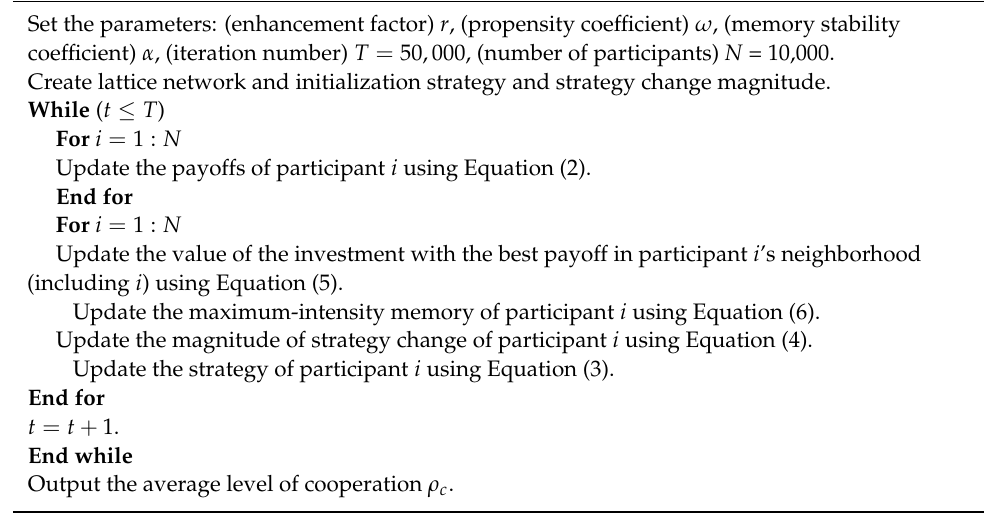
Algorithm 1: PGG Based on PSO with Memory Stability